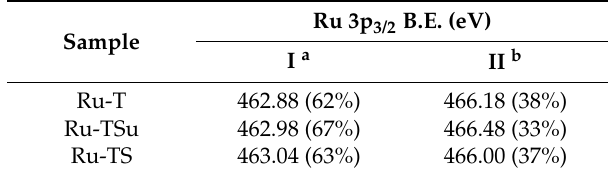
Table 5. Binding energy of Ru 3p and proportion of the two Ru species (in